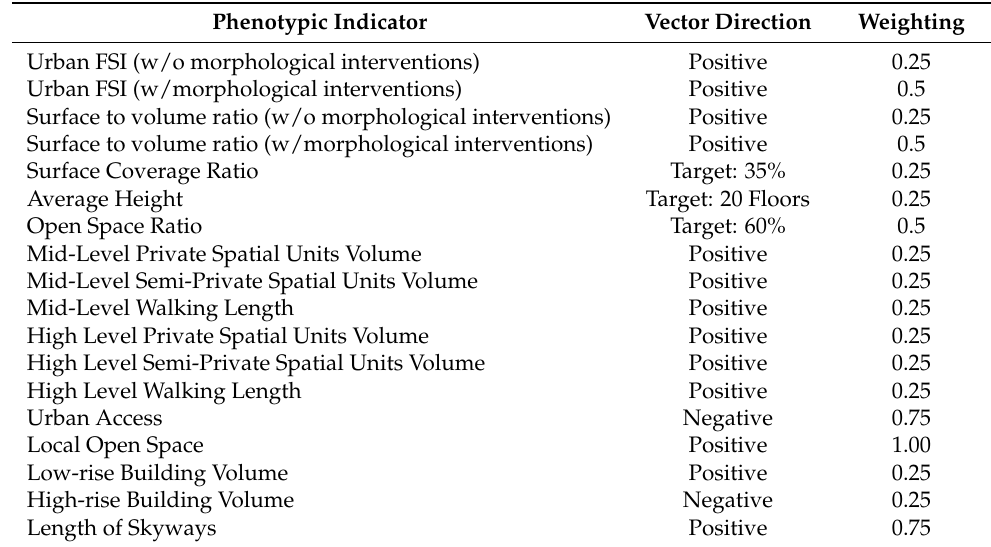
Table 2. Each solution carried forward from the first stage of selection was evaluated according to the phenotypic indicators and weights listed